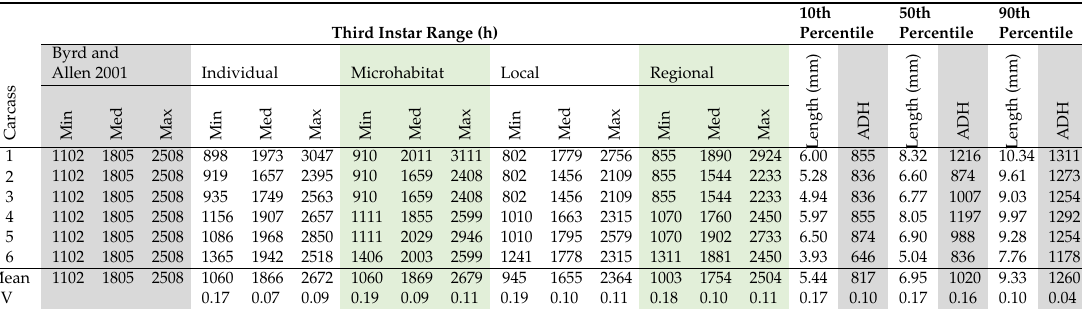
Table 2. Actual and expected minimum (Min), median (Med), and maximum (Max) accumulated degree hours (ADH) associated with Phormia regina development, using a minimum developmental threshold of 6 ◦ C, based on third instar range (time present on carcass) and body lengths representing the 10th, 50th, and 90th percentiles. White and green areas represent actual values while gray areas represent expected values